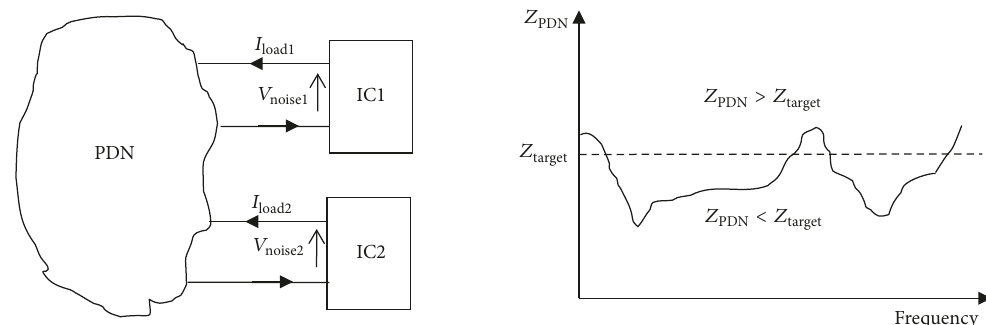
Figure 1: Example of PDN impedance versus